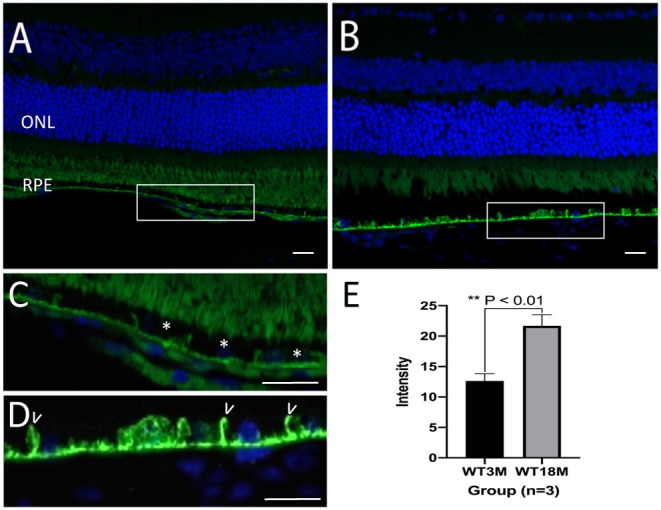
Immunreactivity of GzmB in Bruch's Membrane and RPE layer of a young (3 month) and old (18 month) C57Bl/6J mouse retina. (A) GzmB immunoreactivity (green, 488 nm) is lower in mouse retina from 3 month old mouse compared to (B) an 18 month old mouse. Boxed areas are shown at higher power in (C) with GzmB punctate labeling (*) on Bruch's membrane of 3 month old, and in (D) which demonstrates stronger immunofluorescence intensity along BM and between RPE cell borders (some shown by white arrowheads) of the older mouse retina. (E) Independent-sample T-test (n = 3) between two groups shows the increased GzmB level in BM and RPE layers of 18M mice: mean ± SEM; *p < 0.01. DAPI (405 nm) labeling of nuclei is shown in blue. Scale bar = 20 μm.